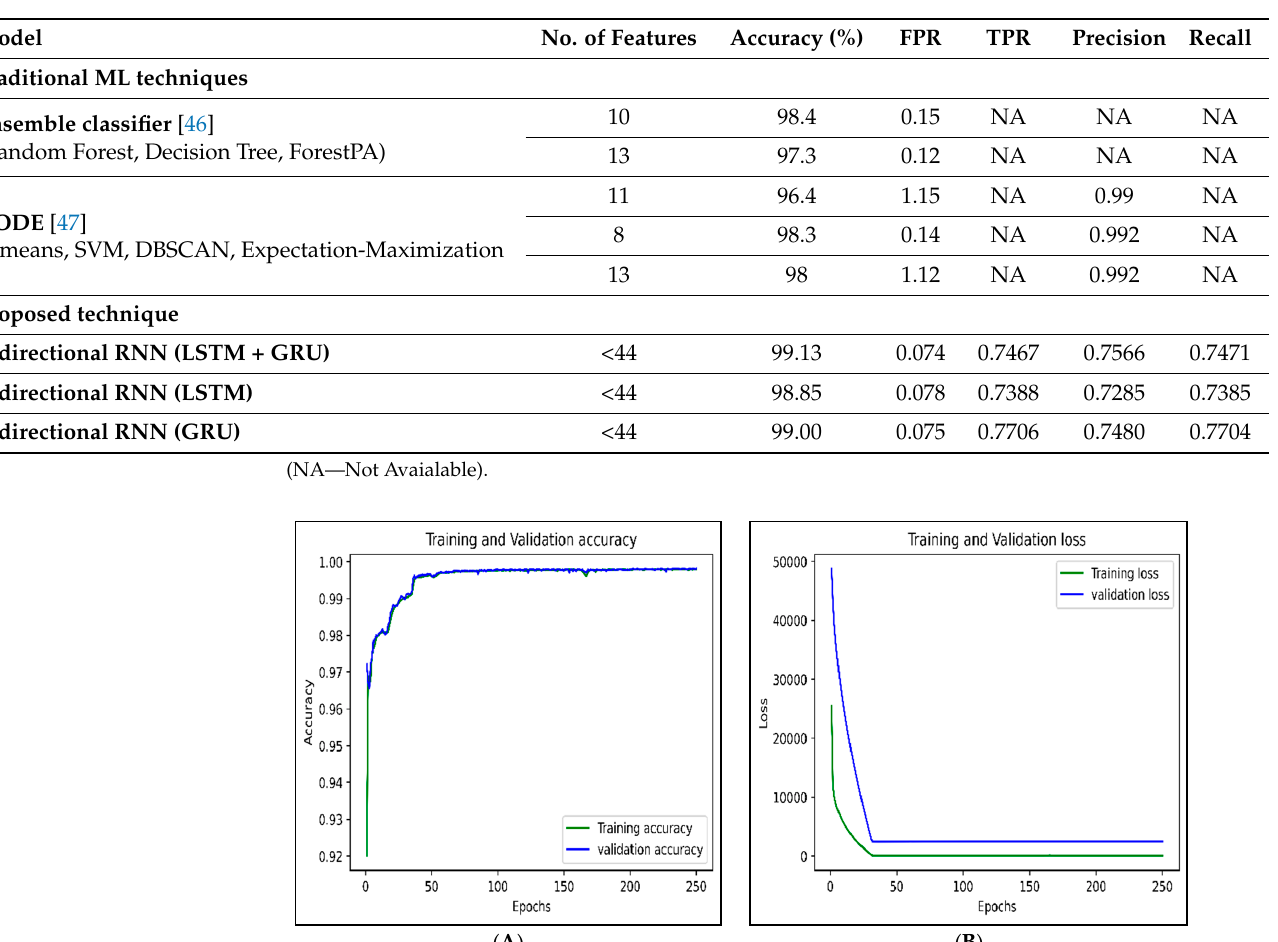
Table 13. Performance comparison (traditional vs. proposed model).